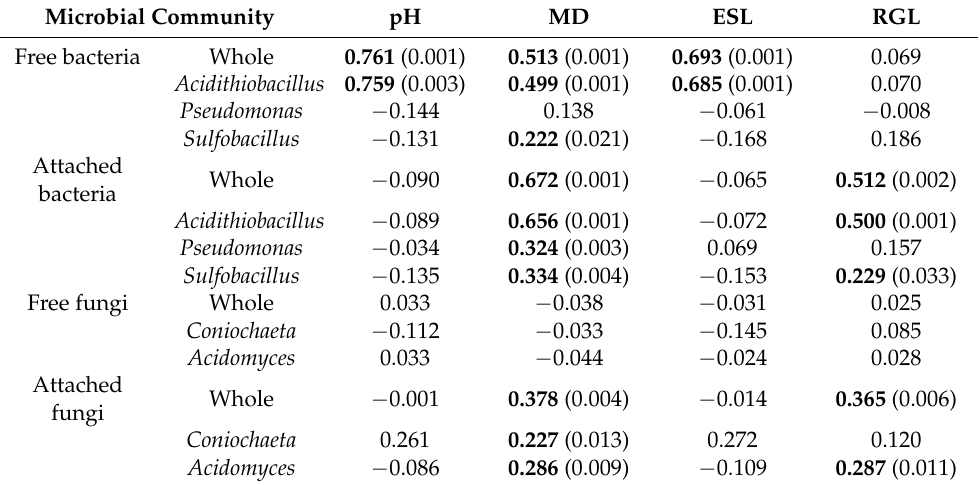
Table 5. Mantel test analysis for the relationships between microbial data and solution environmental factors, including pH, MD (microbial density), ESL (elevated sulfate radical level), and RGL (reduced glucose